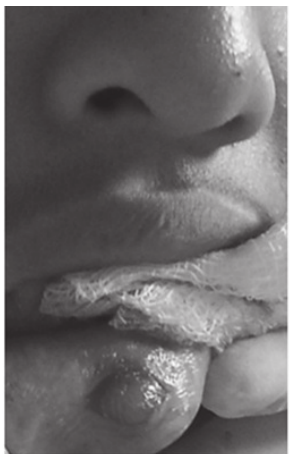
Figure 1. Picture showing swelling on the labial mucosa